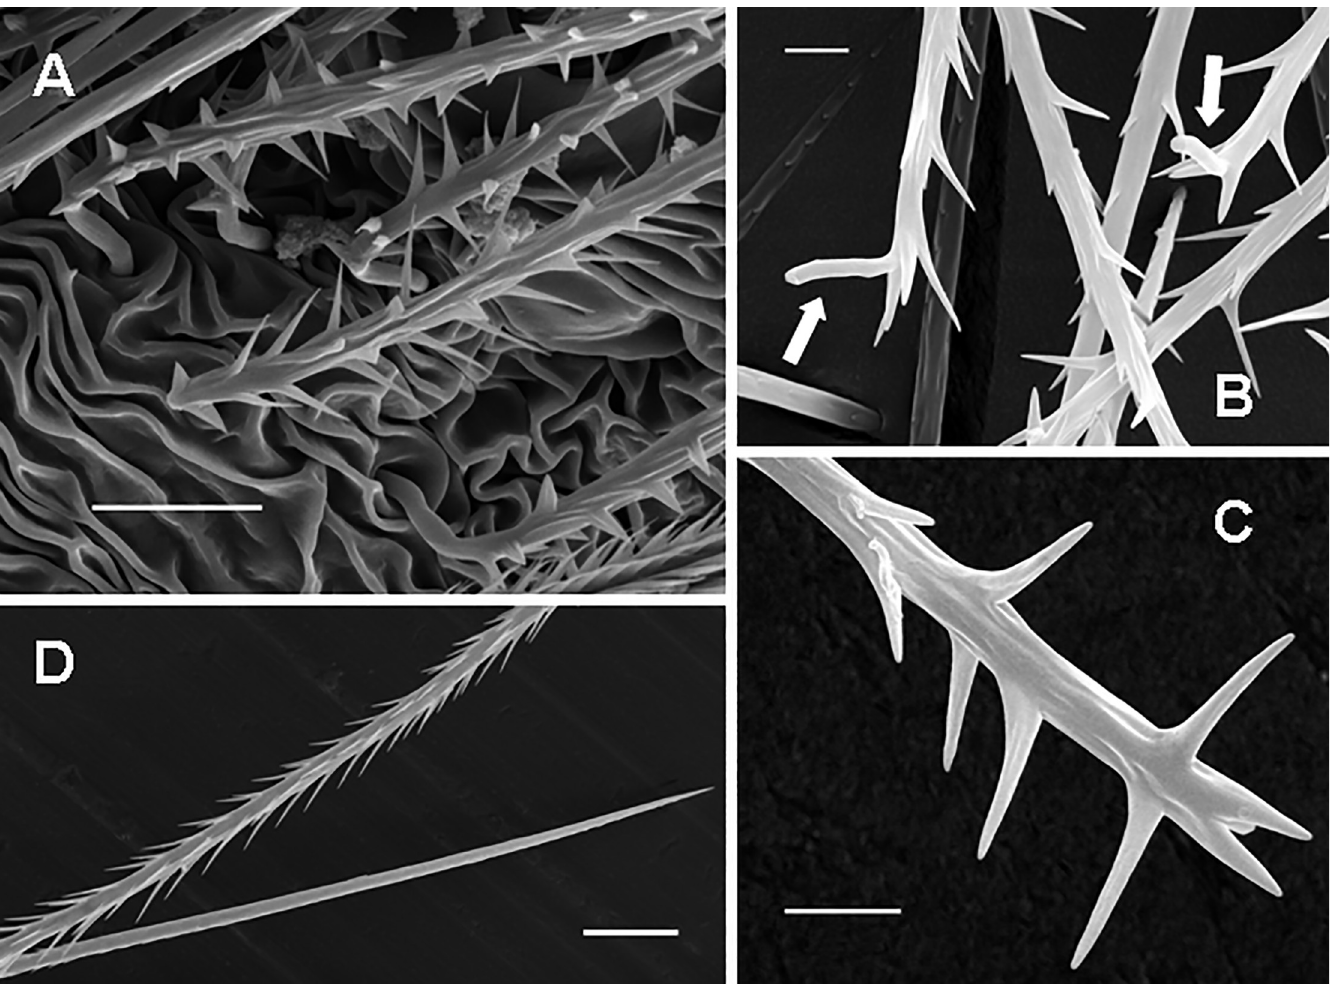
Fig 11. Urticating setae of type III. (A) Cyriocosmus perezmilesi , juv., a stage of the first nymph (according to Foelix [56]). Ontogenetic precursor of type III urticating setae, detail of the basal sections with non-reversed barbs. The arrangement of barbs in this stage is congruent with that of body setae presented by Bertani & Guadanucci [9]: Fig 25. Scale bar = 10 μ m. (B) Hapalopus sp., juv. (car. 1.8), Lara State, Venezuela. Type III, supporting stalks in the basal sections marked by arrows. Scale bar = 5 μ m. (C) Hapalopus sp., juv. (car. 1.8), Lara State, Venezuela. Type III urticating seta with unusually developed basal barbs, detail of the basal section. Scale bar = 5 μ m. (D) Hapalotremus sp., a female from Peru. Type III, the apical (lower urticating seta) and the basal section (upper urticating seta). Scale bar = 20 μ m. Abbreviations: juv. = juvenile specimen; car. = length of carapace.